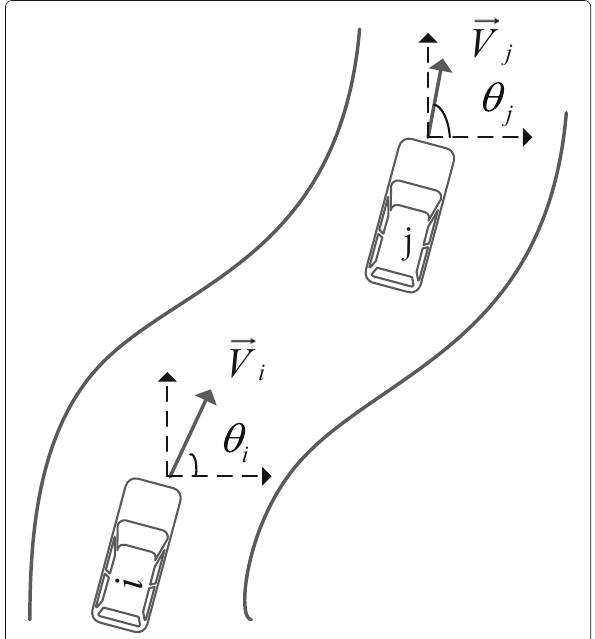
Fig. 2 Prediction model for communication connection